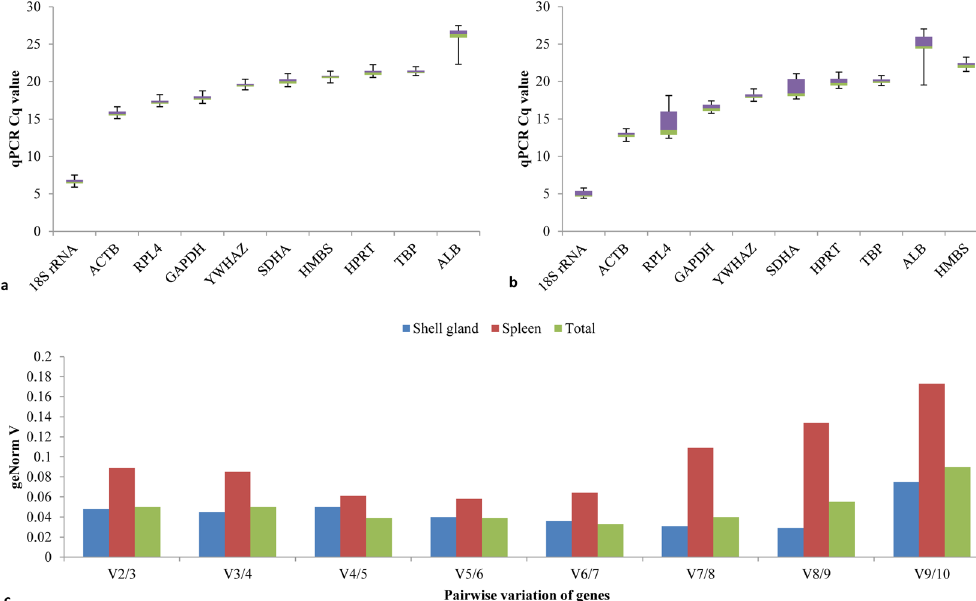
Figure 3. Effect of IBV challenge on the expression stability of 10 reference genes in the shell gland and spleen. Mean Cq values of the control, IBV T and Vic S strains challenged groups in the shell gland ( a ) and in the spleen ( b ). A square across the box is depicted as the median. The box indicates the 25th and 75th percentiles and the whiskers caps represent the maximum and minimum values ( c ) Pairwise variation (geNorm V) of genes in the shell gland (control, IBV T and Vic S strains challenge groups together), in the spleen (control, IBV T andVic S strains challenge groups together) and in the combined data set of the shell gland and spleen. In qbase + software, geNorm V was calculated as standard deviation of the log 2 transformed relative quantities between those two genes. The geNorm V analysis started with the two most stably expressed genes being compared to the pair including the third (V2/3), and the process continued until the least stable gene was added (i.e.